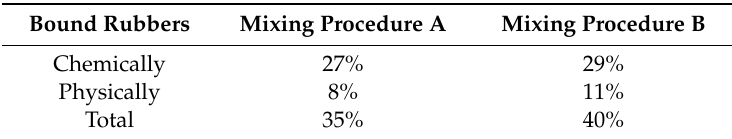
Figure 4. Bound rubber content as a function of ( a ) silanization temperature and ( b ) silanization time; ( ): total bound rubber; ( ): chemically bound rubber; ( ): physically bound rubber. Table 4. Amount of bound rubber of mixing procedures A and B corresponding to the reference silanization condition (150 °C and 150 s).